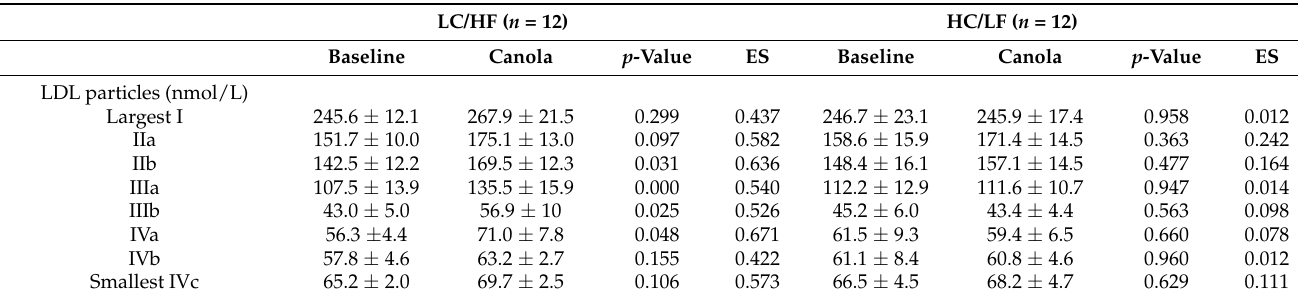
Table 3. Baseline and Canola Oil (Run-In) Diet plasma phospholipid fatty acid responses in the low-carbohydrate/high-fat (LC/HF) and high-carbohydrate/low-fat (HC/LF) groups. LC/HF ( n = 12) HC/LF ( n = 12)